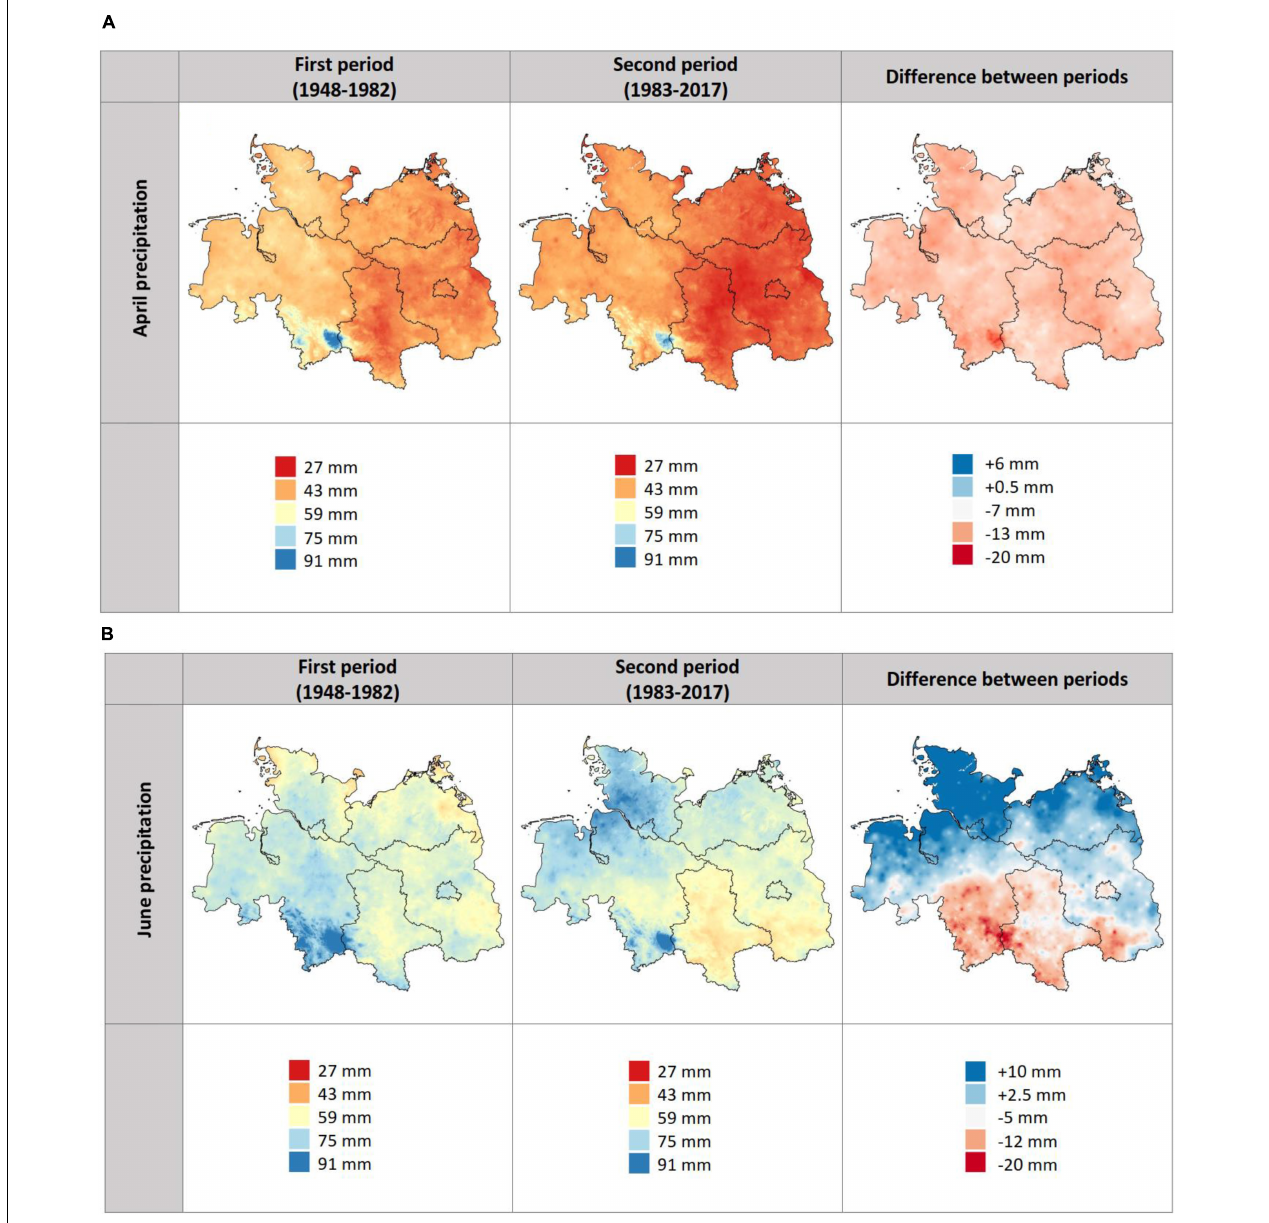
FIGURE 5 | Interpolation (DWD 1 km 2 -gridded climate data) of April (A) and June precipitation (B) in the North German Lowlands: means of the periods 1948–1982 (left) and 1983–2017 (center), and differences between the two period means (right). Positive differences: increase, negative differences: